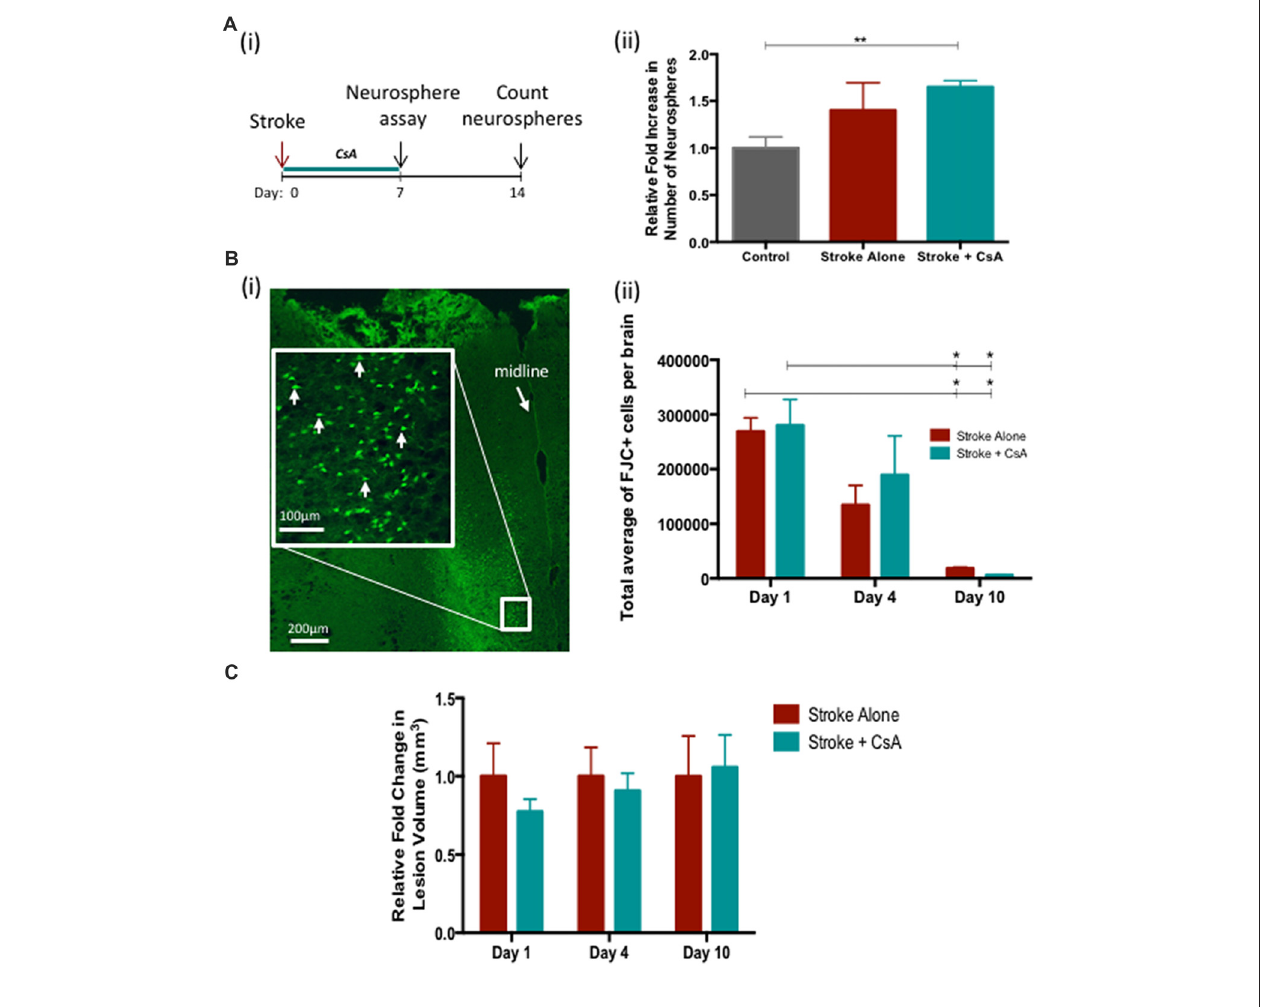
FIGURE 2 | Cyclosporin A (CsA) expands the neural precursor cell (NPC) pool and is not neuroprotective. (Ai) Timeline of the experiment. Neurosphere assay was performed on day 7 following Stroke and counted 7 days later. (ii) Stroke-Alone ( n = 6) results in a slight 1.4 fold increase, while Stroke+CsA ( n = 5) caused a significant 1.7 fold increase ( n = 7 controls); ∗∗ p < 0.01. (Bi) Fluoro Jade C+ (FJC+) cells in the lesioned mPFC (white arrows). (ii) There was no significant difference in FJC+ cell counts between Stroke-Alone and Stroke+CsA groups on day 1 ( n = 5/group), 4 ( n = 5/group) or 10 ( n = 3/group) post-stroke. (C) Lesion volumes are not significantly different between stroke-alone and stroke+CsA groups ( n = 5/group) ∗ p <